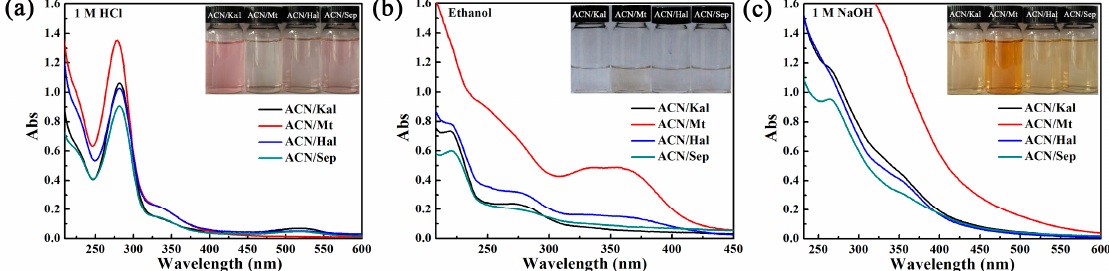
Figure 6. Spectra and digital images of the ACN solutions desorbed from the hybrid pigments after being treated with ( a ) 1 M HCl, ( b ) ethanol and ( c ) 1 M NaOH for 24 h, respectively. Table 3. Color parameters of hybrid pigments after being treated with 1 M HCl, ethanol, 1 M NaOH for 24 h, respectively.